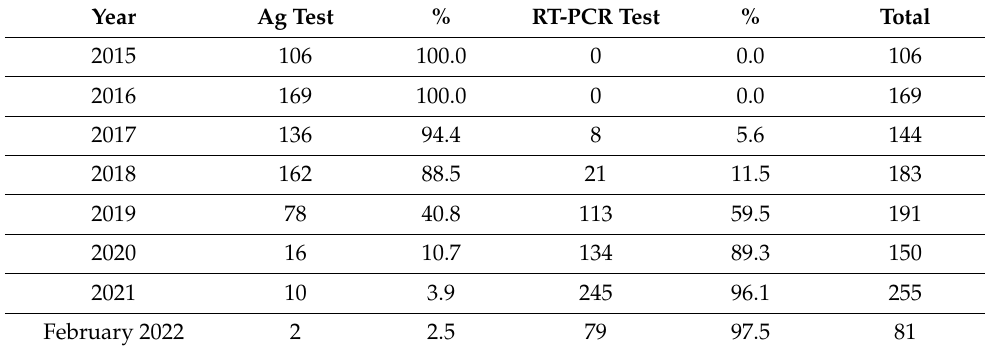
Table 1. Annual frequency of RSV testing according to the type of